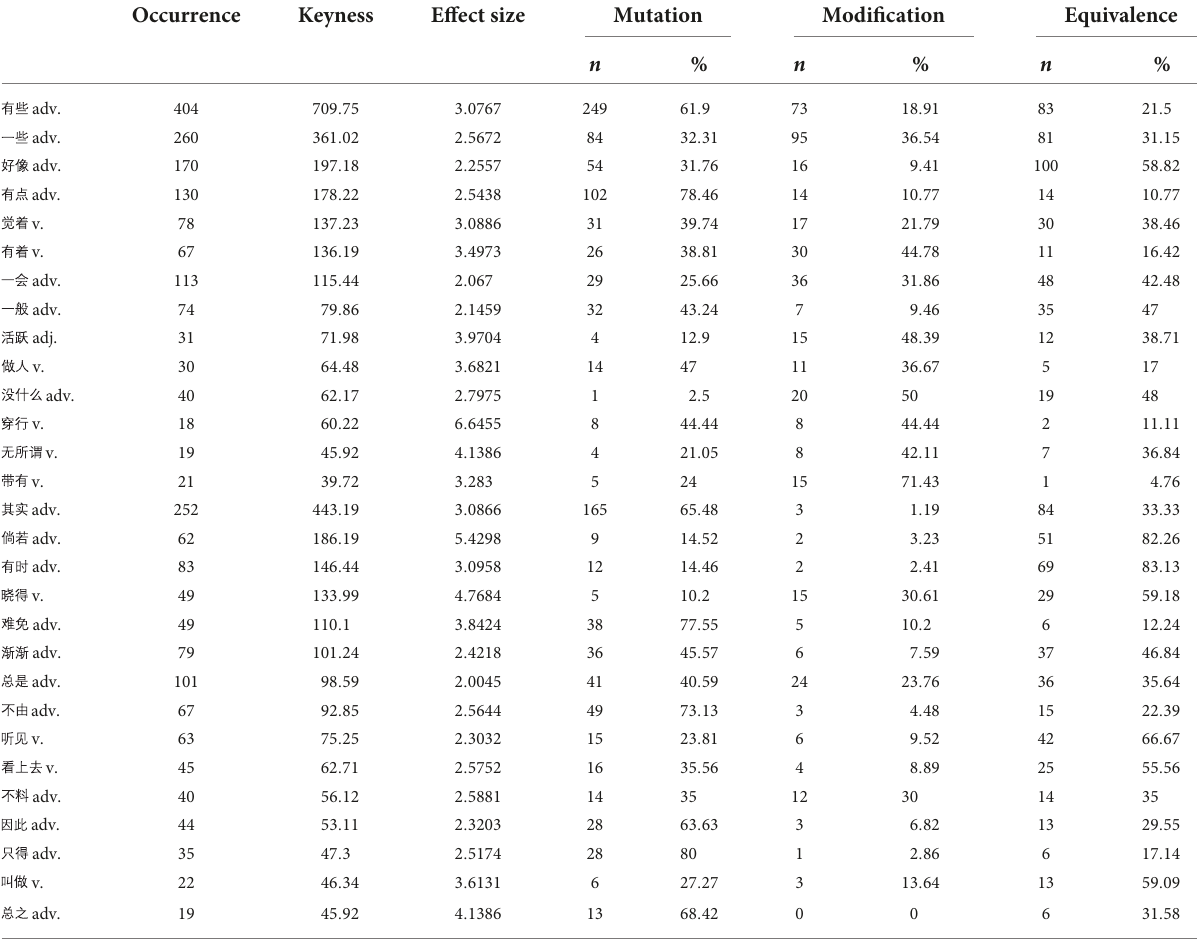
TABLE 4 Translation strategies for the ST